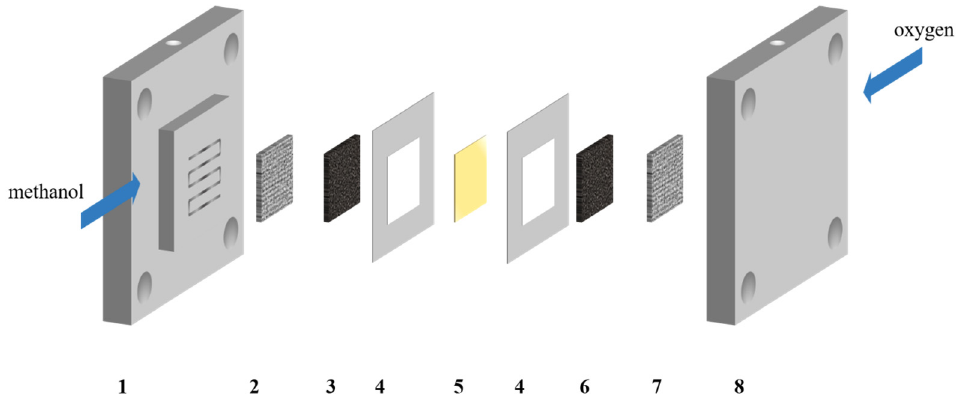
Figure 1. Schematic diagram of DMFC assembly. (1) anode plate; (2) anode diffusion layer; (3) anode catalytic layer; (4) gasket; (5) Nafion membrane; (6) cathode catalytic layer; (7) cathode diffusion layer; (8) cathode plate.